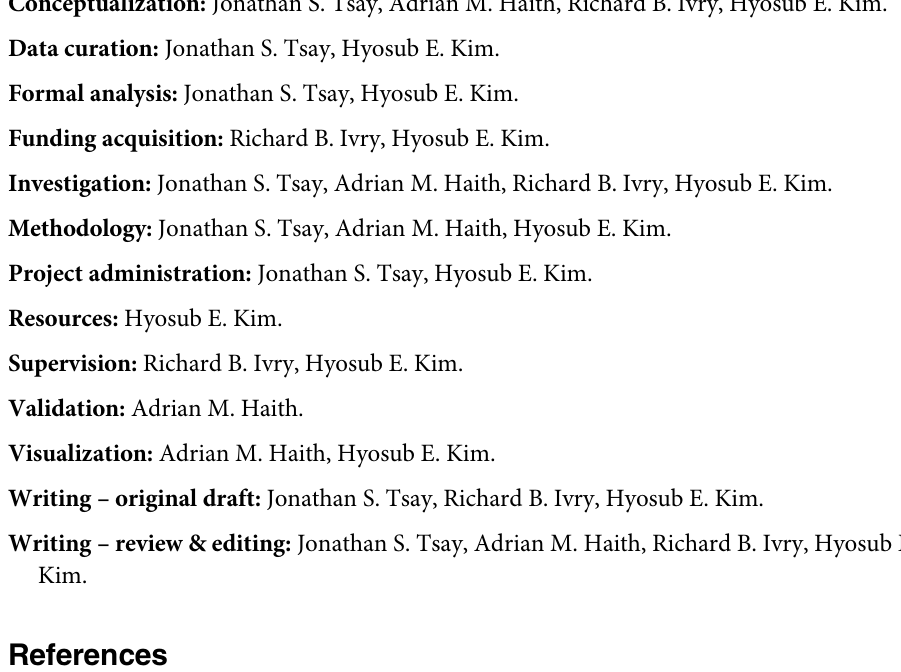
S1 Table. A kinematic comparison across experiments. S2 Table. TE-only fails to elicit implicit recalibration in response to small target displace-